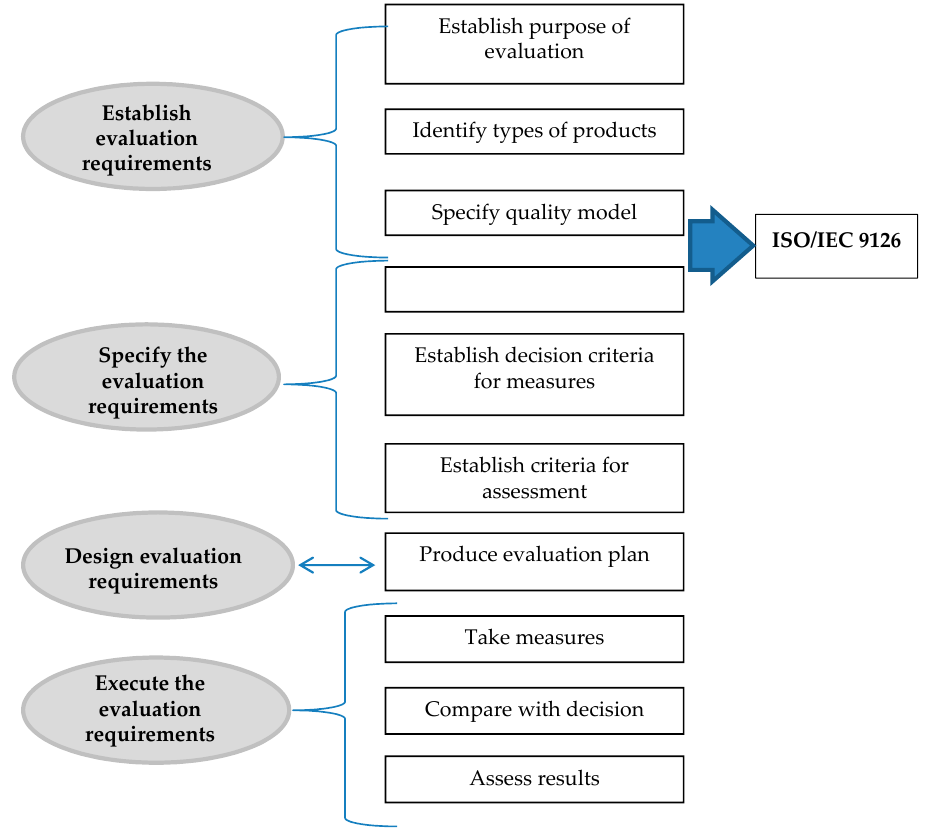
Figure 6. Software solutions evaluation procedure in compliance with the ISO/IEC 14598 standard.